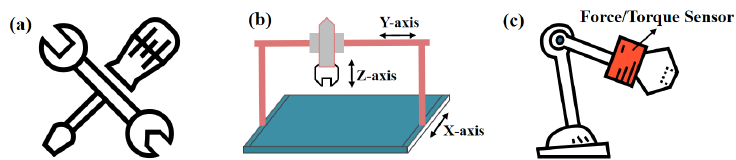
Figure 1. Three ways of performing the screw fastening and unfastening tasks. ( a ) Manual operation using a wrench or screwdriver. ( b ) Automatic operation using a Cartesian robot. ( c ) Automatic operation using an articulated robot.